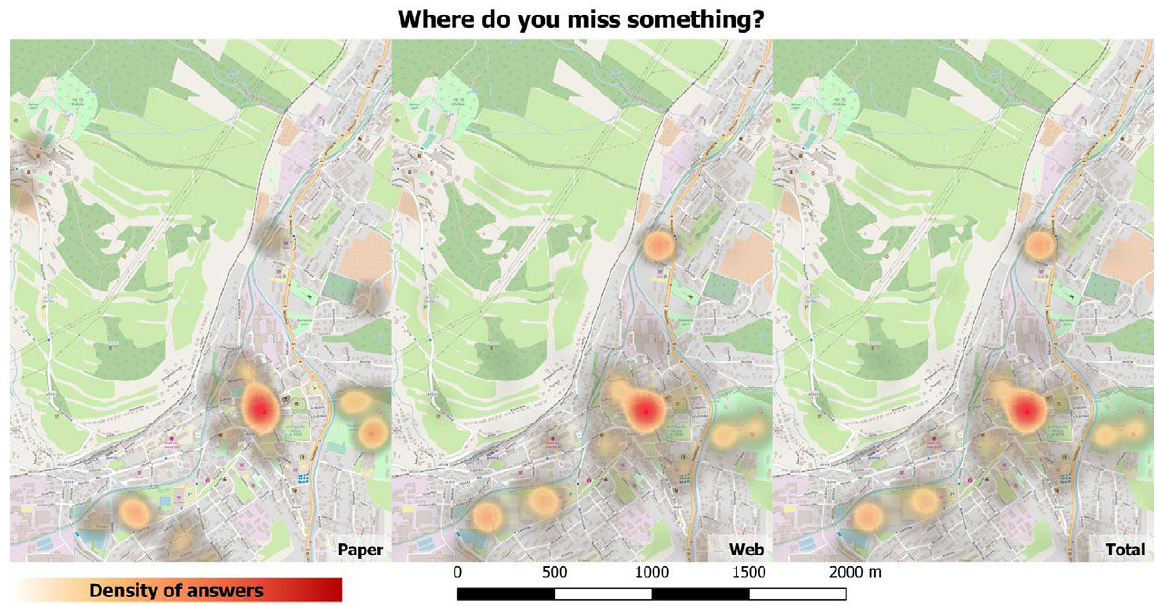
Fig. 8. Where do respondents miss something in Jeseník?